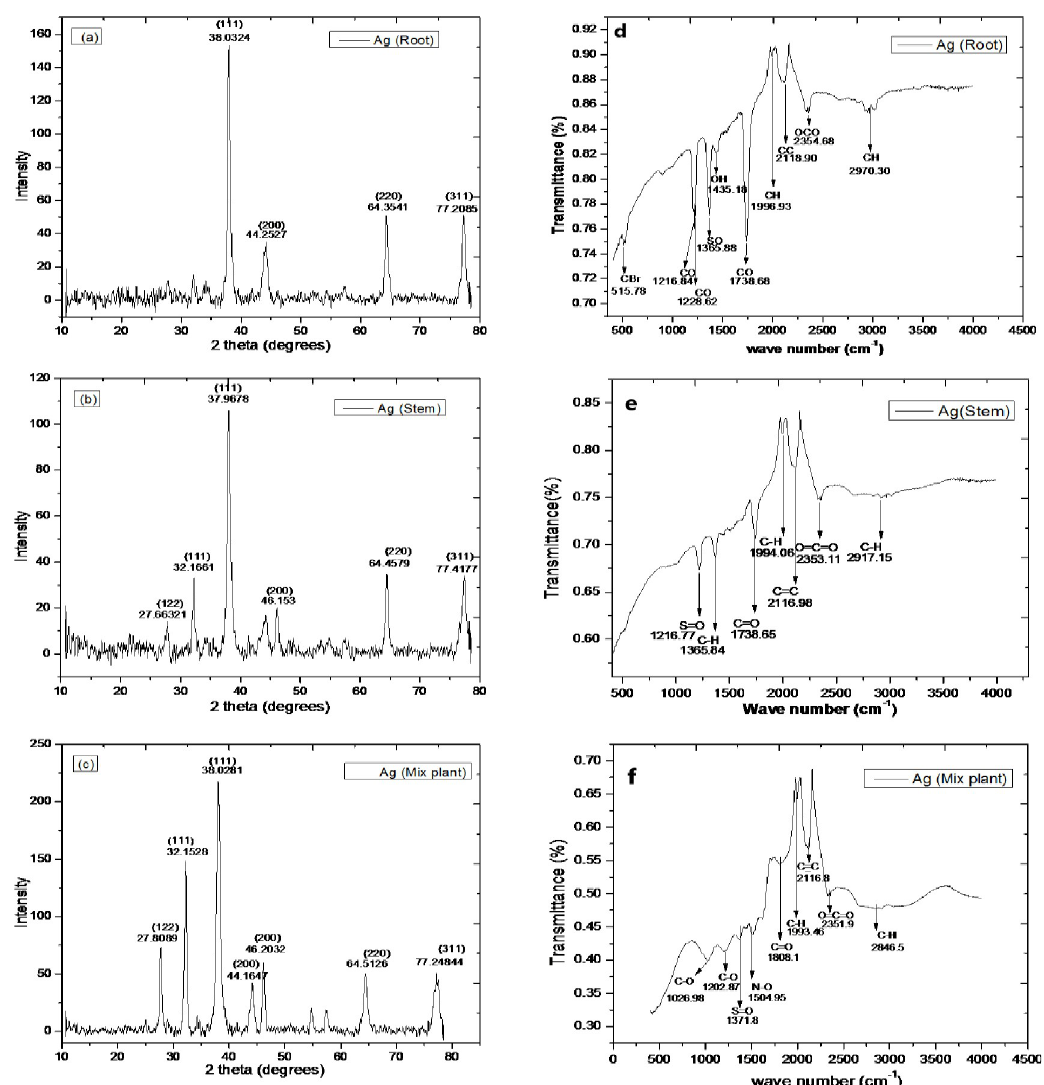
Fig 3. X-ray diffraction (XRD) ( a-c ) and fourier transform infrared spectroscopy (FTIR) ( d-f ) profiles of the R-AgNPs, S-AgNPs and RS-AgNPs